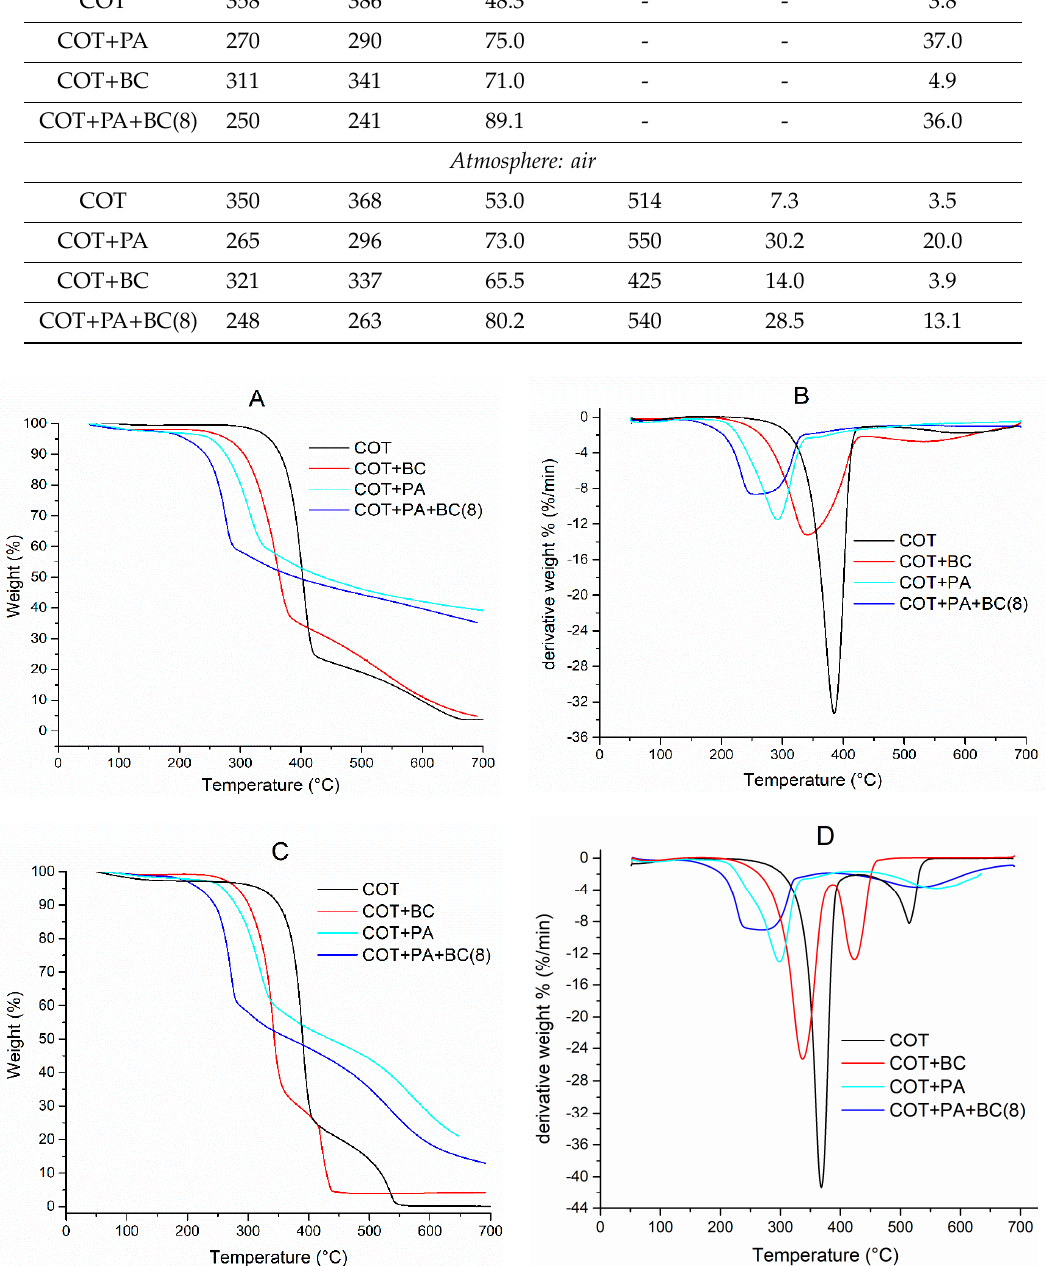
Figure 9. Thermogravimetric (TG) and dTG curves in N 2 ( A , B ) and air ( C , D ) of untreated and treated cotton fabrics.